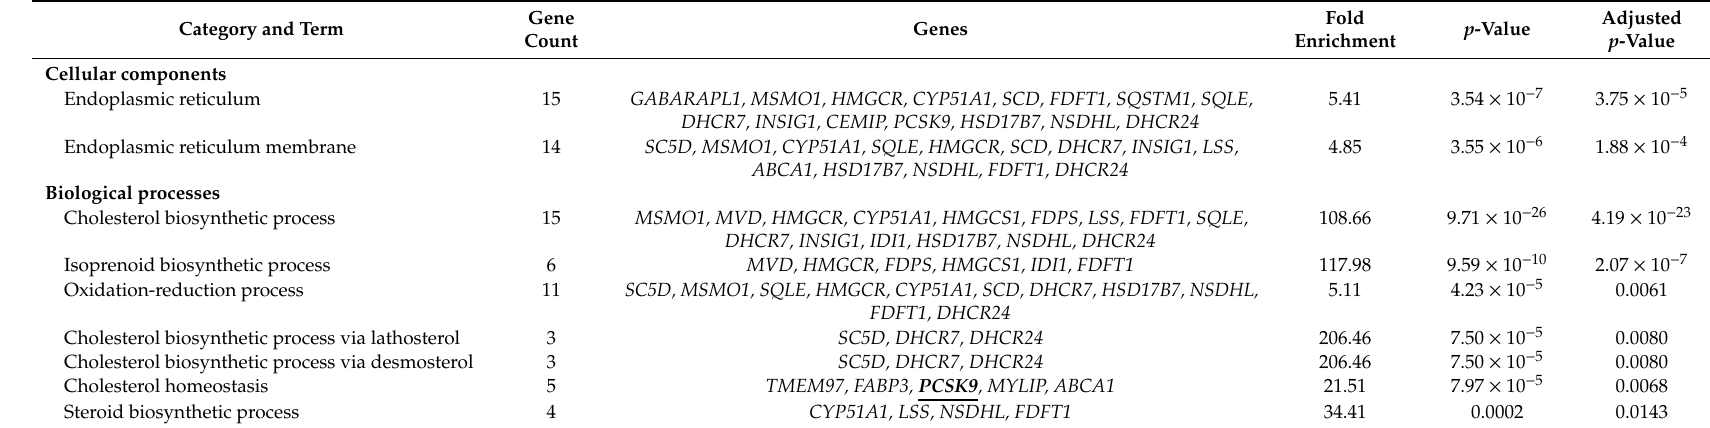
Table 2. Gene ontology analysis of the 61 di ff erentially expressed genes in idiopathic pulmonary fibrosis (IPF) fibroblasts treated with epigallocatechin gallate (EGCG) using the Database for Annotation, Visualization and Integrated Discovery